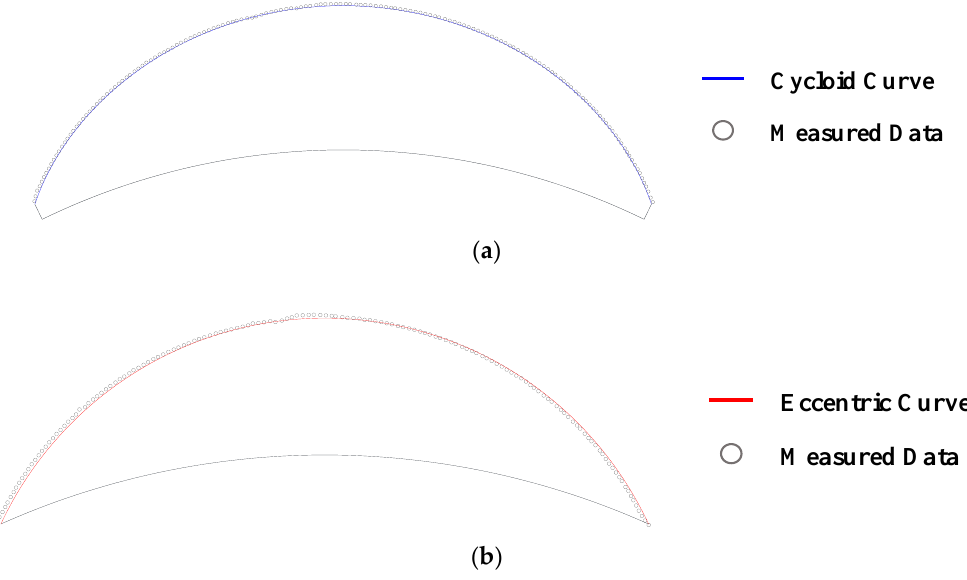
Figure 13. Measured shape of magnet: ( a ) cycloid; ( b ) eccentric.